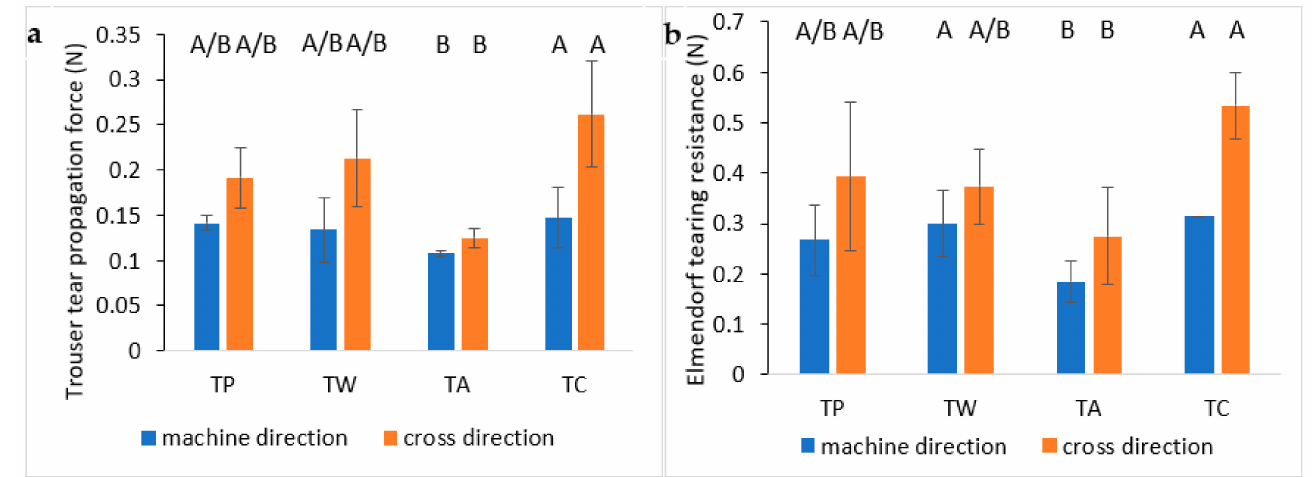
Figure 11. Tear propagation force ( a ) measured through trouser test and tear propagation resistance ( b ) measured with Elmendorf pendulum. Significance of standard deviation was investigated with a Tukey HSD post hoc test performed on 4 different specimens for Elmendorf test and on 5 different specimens for tear propagation test. On the top of each column, a letter was reported. Means that were identified as not significantly different were grouped under the same